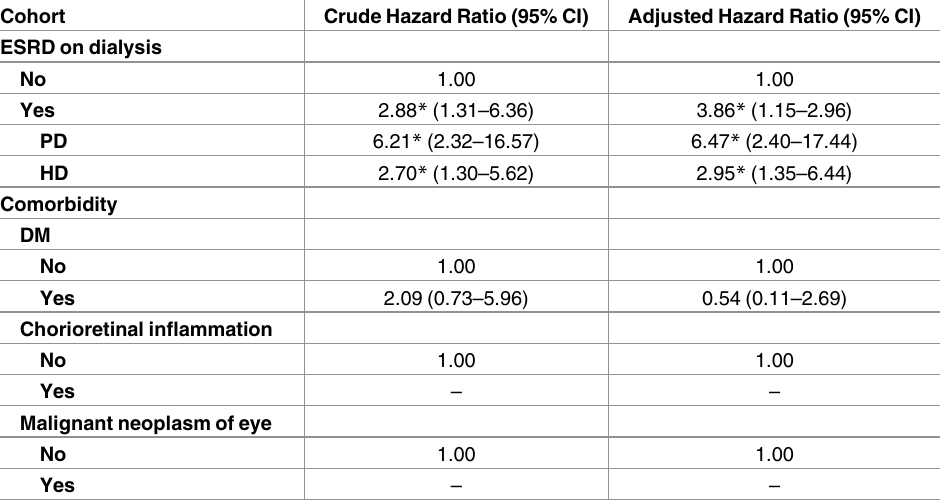
Table 3. Crude and adjusted hazard ratios of conditional Cox proportional hazard regressions and 95% confidence intervals with the Firth method for serous retinal detachment during the follow-up period in the study cohort.